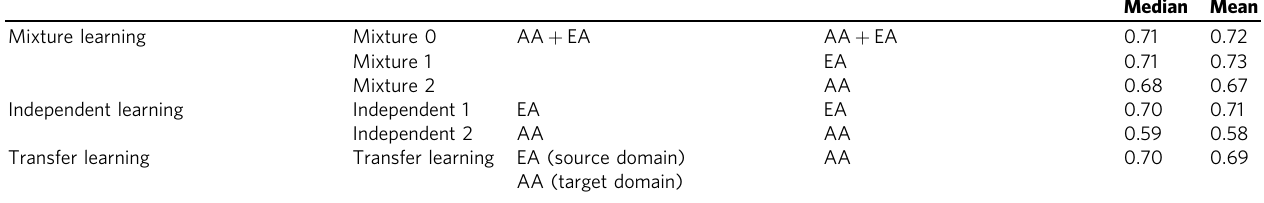
Table 1 The machine learning experiments.